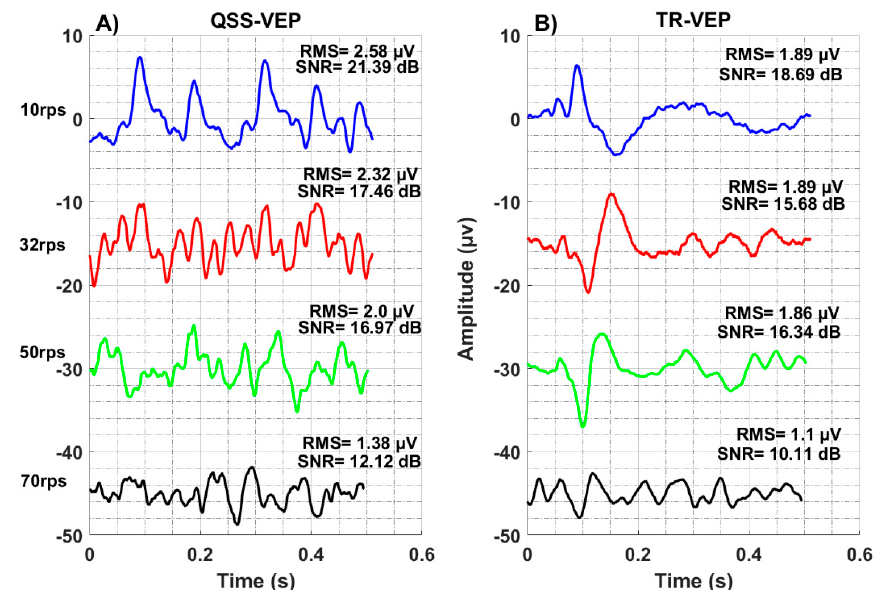
Figure 2. Population average left field quasi-steady-state-visual evoked potentials (QSS-VEP) ( A ), and transient-visual evoked potentials (TR-VEP) ( B ) plots are shown. (A) 10 rps, 32 rps, 50 rps, and 70 rps QSS-VEPs are at the left. (B) TR-VEPs are at the right. Note the morphology change in the TR-VEPs by rate from 10 rps to 32 rps.